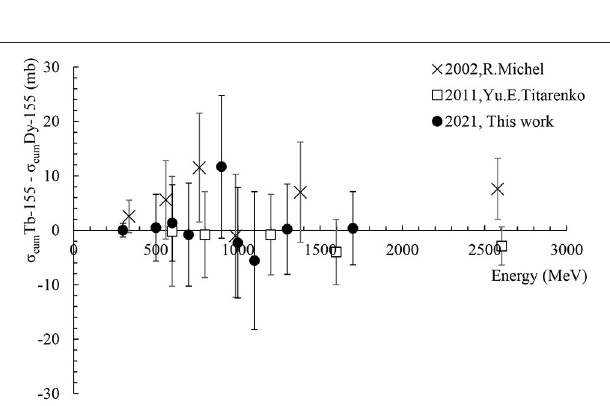
FIGURE 4 | Cumulative cross-section for Tb-152 production as a function of the proton beam energy.